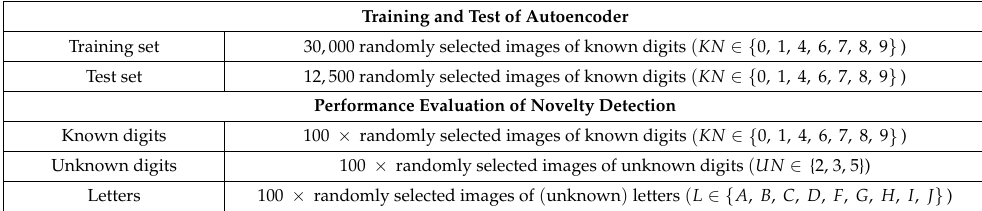
Table 2. Used dataset for the evaluation benchmarks.